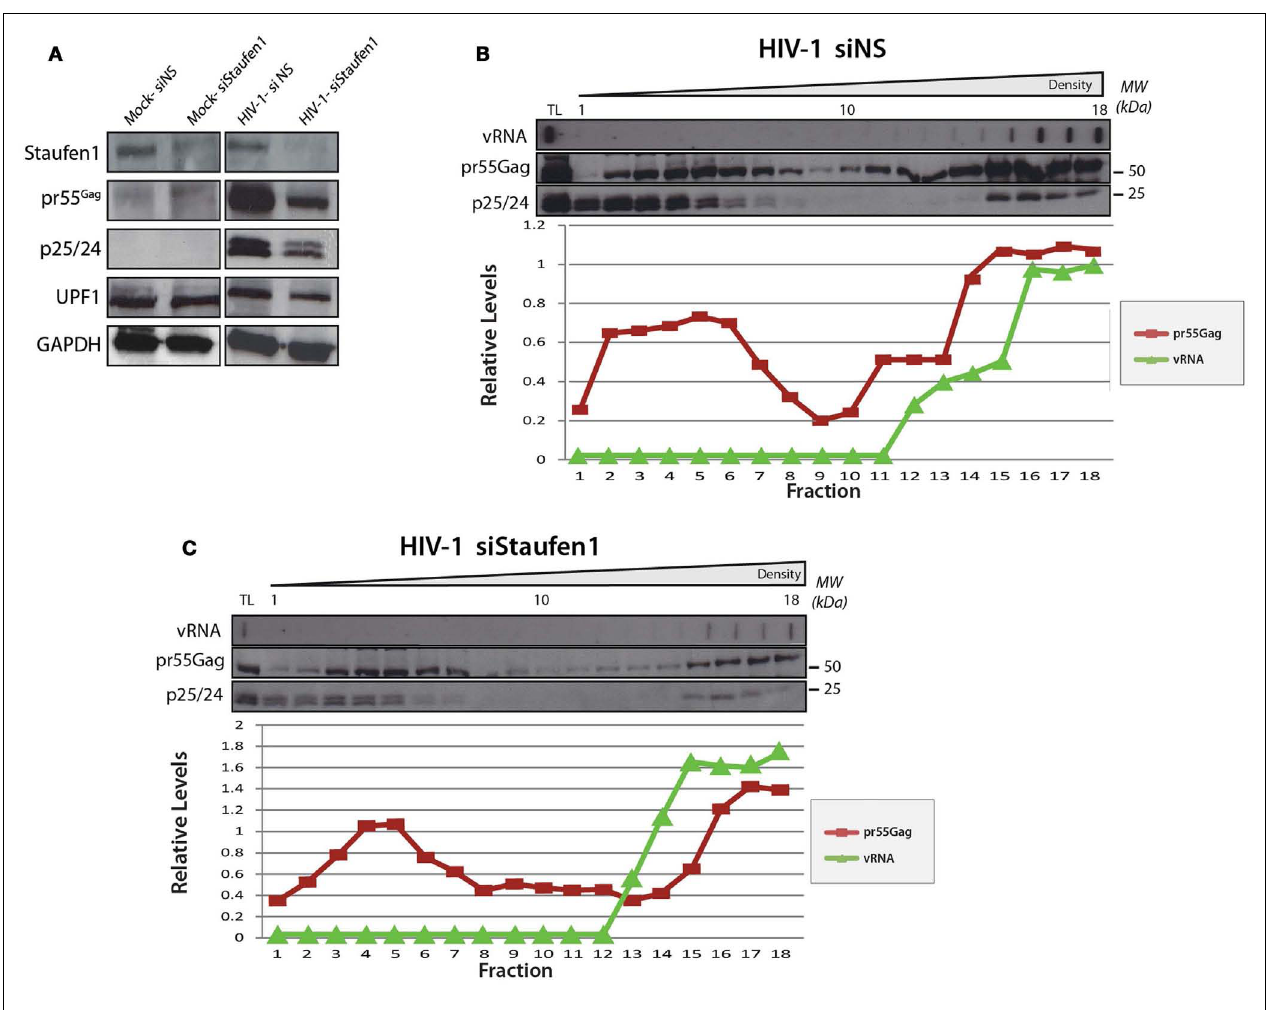
lysates from siNS-treated (B) and siStaufen1-treated (C) cells were fractionated on 5–50% sucrose gradients and 19–20 fractions were collected for further analysis by western blotting, as indicated.TL represents the total lysates. HIV-1 viral genomic RNA (9kb, vRNA) was assessed in each fraction by slot blot analysis. Staufen1, Gag and vRNA were quantitated in each fraction by densitometry and relative levels are depicted for each fraction (Blue: Staufen1-HA, Red: Gag, Green: vRNA).